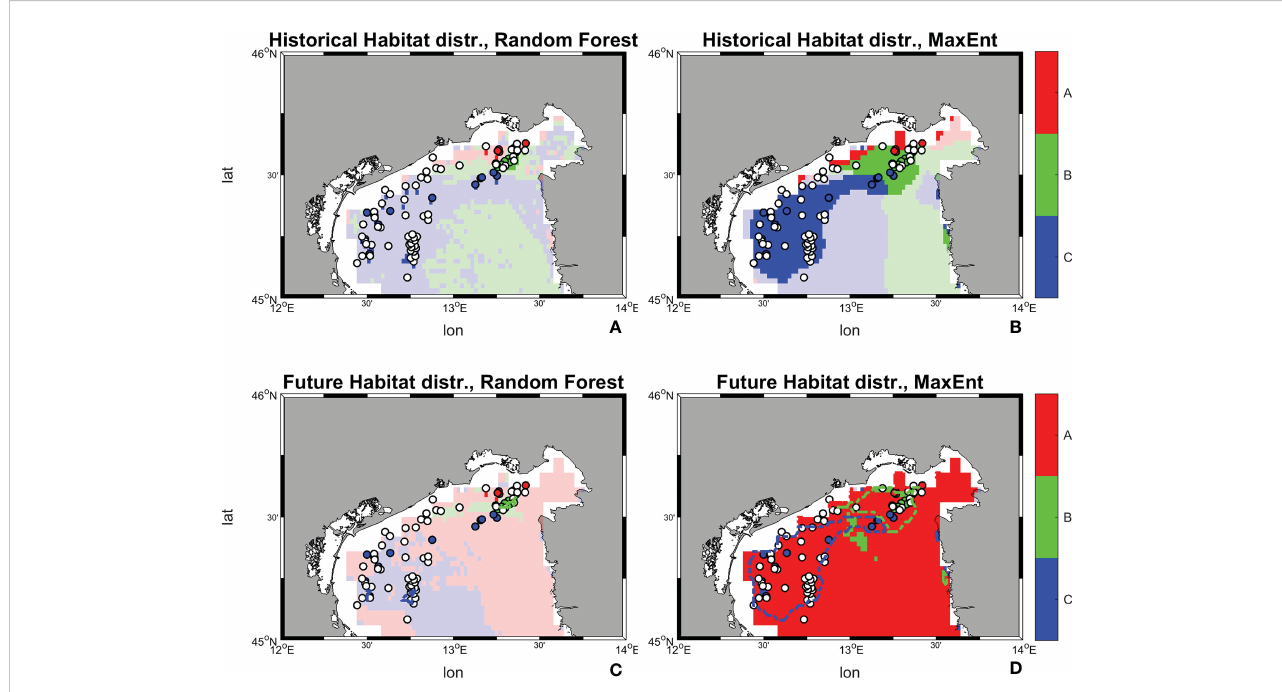
FIGURE 12 Historical and future distribution of dominant habitats (maximum suitability) according to Random Forest and MaxEnt models. (A) Historical distribution of habitats predicted by Random Forest; (B) Historical distribution of habitats predicted by MaxEnt; (C) Future distribution of habitats predicted by Random Forest; (D) Future distribution of habitats predicted by MaxEnt. Shaded colors indicate suitability values below a threshold of 0.5, therefore belonging to low-medium ranges, while marked ones stood for values above 0.5 and belonging to high